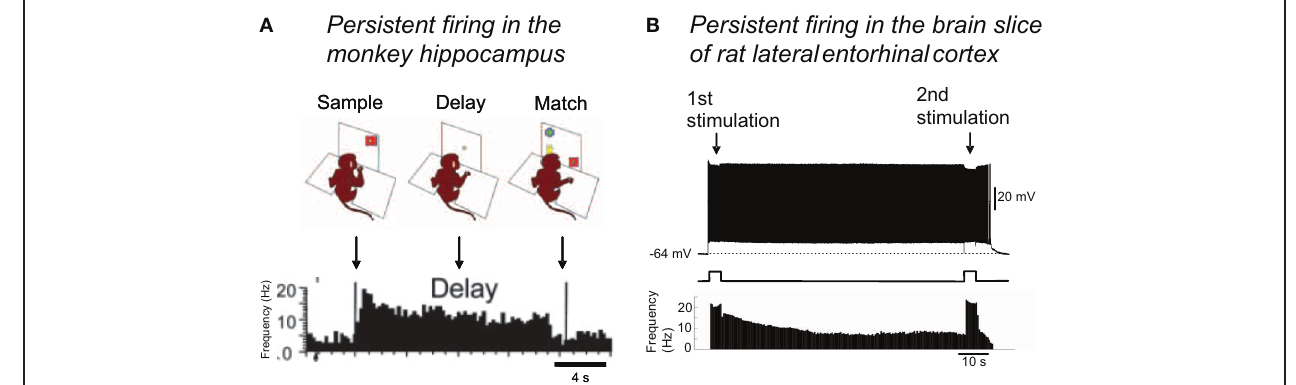
FIGURE 4 | Persistent firing as the mechanism for short-term memory function of the MTL. (A) Persistent firing recorded in monkey hippocampus during a delayed match-to-sample task. Some neurons in the hippocampus continued firing throughout the delay period, when the monkey needed to retain a piece of information presented at the sample phase. (B) In the brain slice preparation of lateral entorhinal cortex, brief (4s) stimulation can trigger